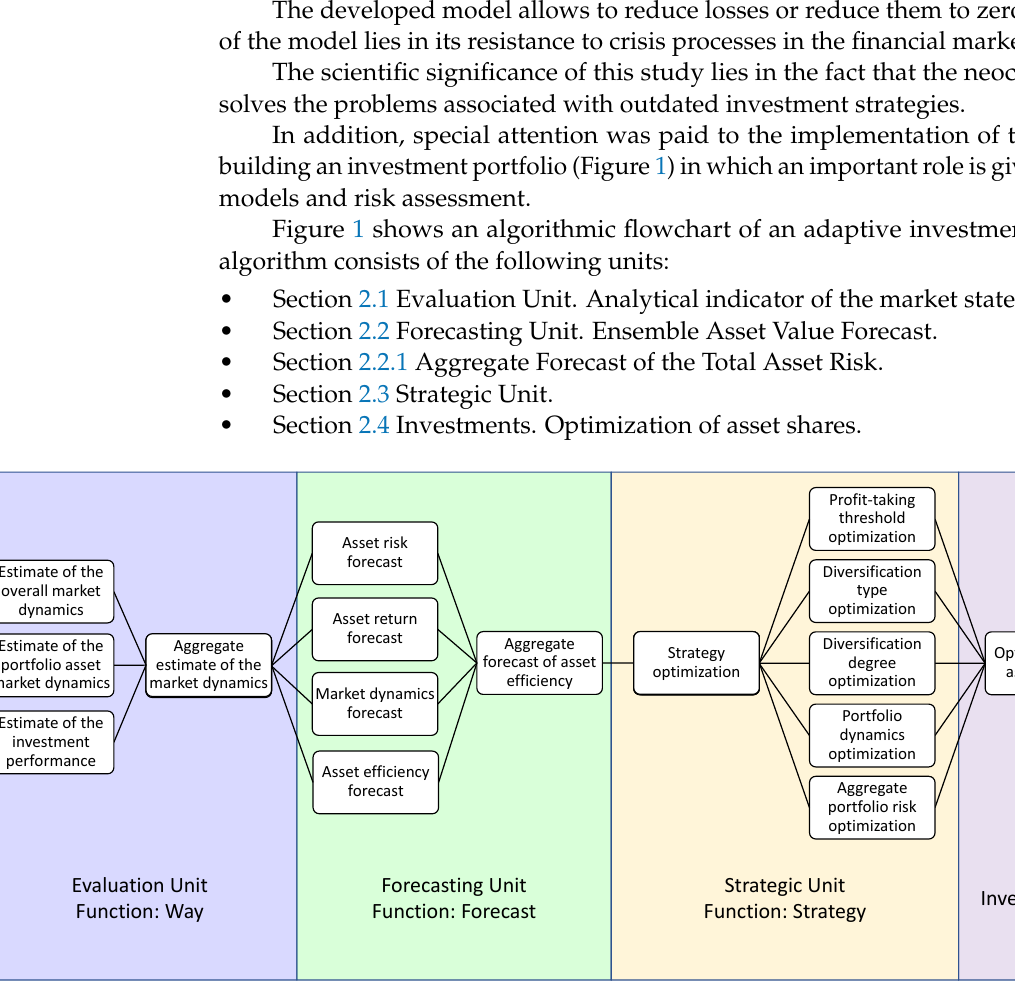
Figure 1. Algorithmic flowchart of an adaptive investment